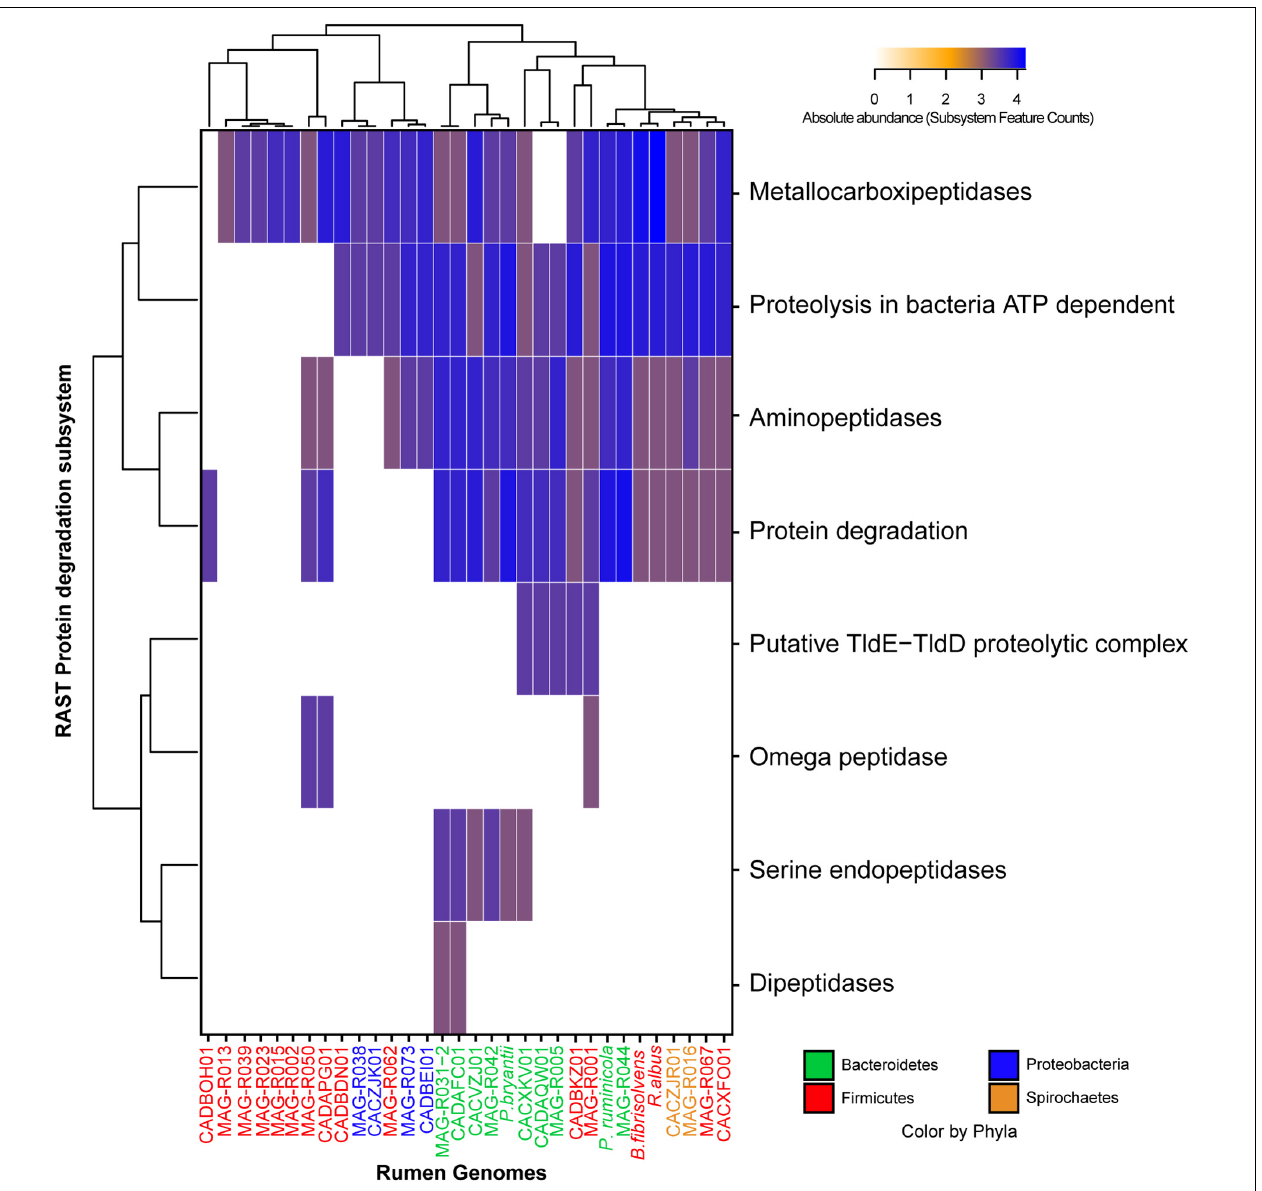
FIGURE 6 | Absolute abundance of the subsystem feature counts found in the protein degradation category established by RAST (rapid annotation using subsystem technology) for each of the representative